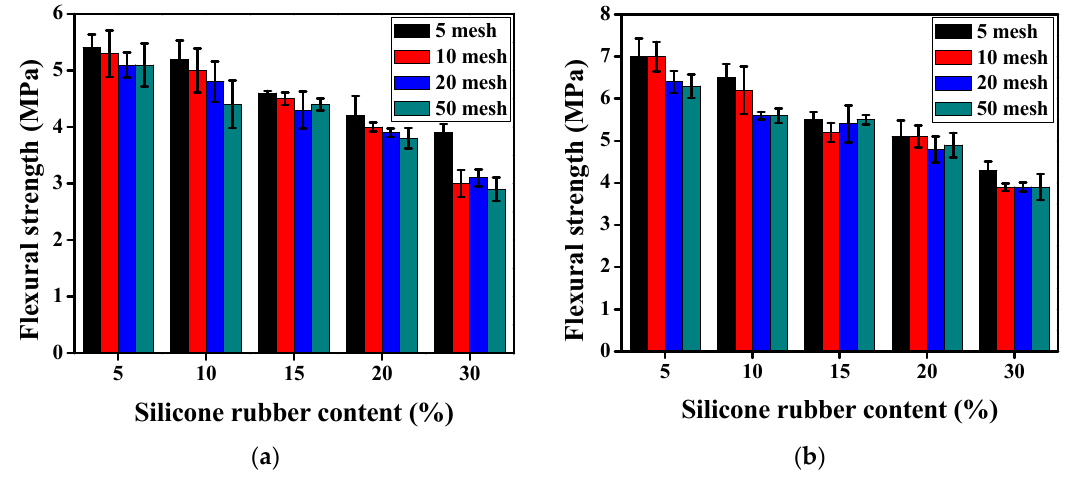
Figure 9. The flexural strength of silicone rubber mortar. ( a ) 7-days; ( b ) 28-days.